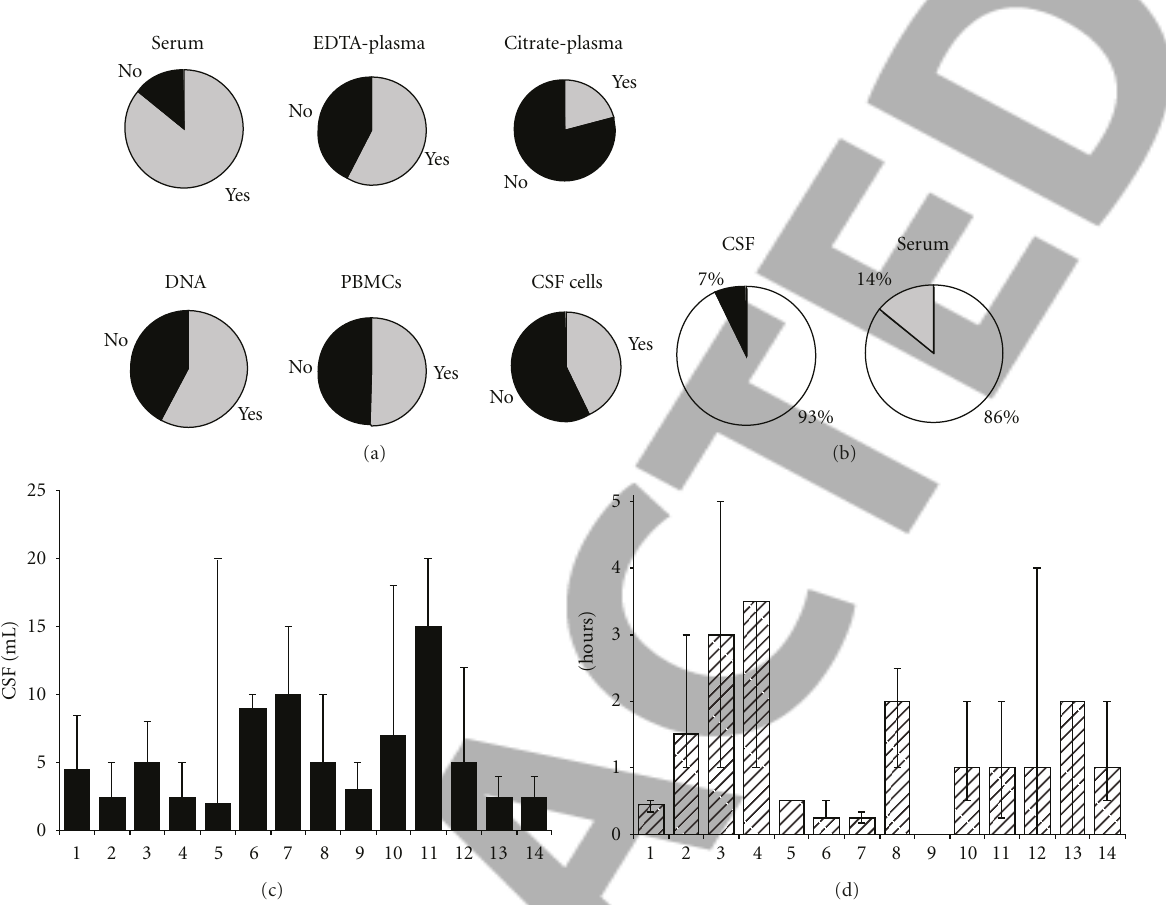
Figure 1: Results of inventory of collection procedures among 14 European centers with CSF biobanks for MS research in 2006. (a) Other body fluids that are collected simultaneously with CSF. Filled area indicates “yes”; open areas: not collected. (b) Storage temperature of CSF and serum. Open area: − 80; closed area: − 20; grey area: not collected. (c) Average volume of CSF that is collected per patient per CSF withdrawal. Bars indicate the average and ranges of volume per center. (d) Time-delay between CSF withdrawal, spinning and storage into the freezer. Bars indicate the average and ranges of time per center.